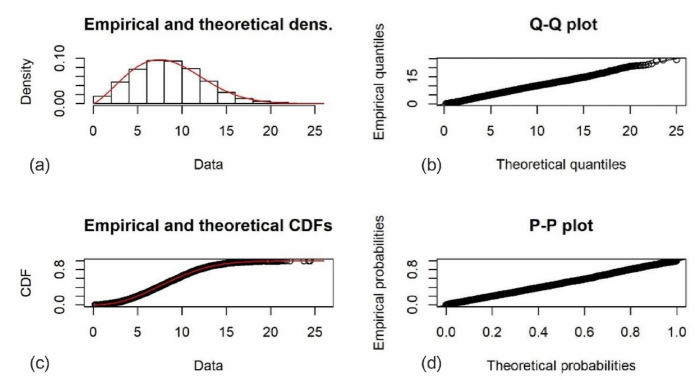
Figure 7. Probability density model fitted on NE wind data at hub height (point 46, Lemnos Plateau) ( a ) data histogram and fitted Weibull function, ( b ) Q–Q plot, ( c ) Cumulative density function, and ( d ) P–P